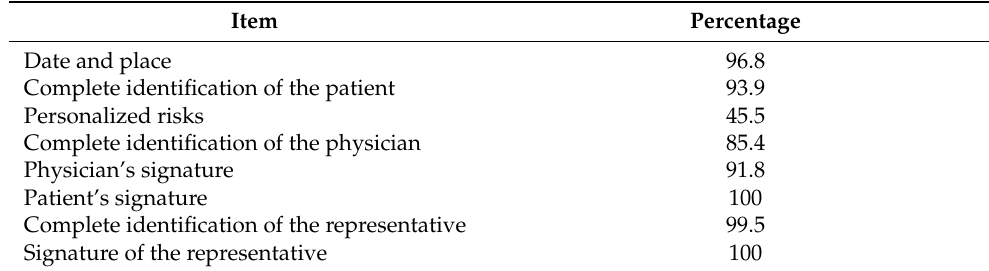
Table 5. Percentage of compliance with the surgical consent forms from the